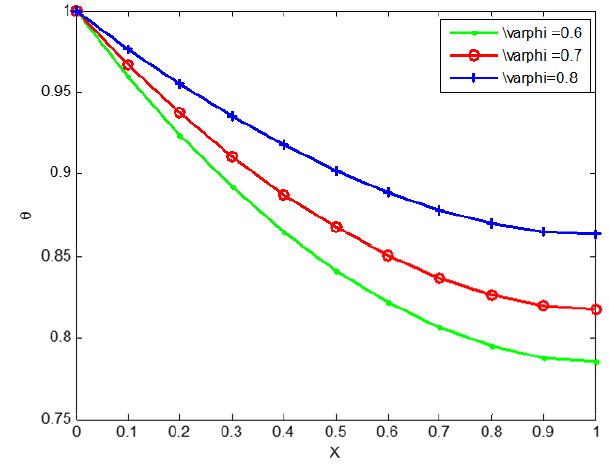
Figure 13. The effect of porosity on the non-dimensional temperature distribution for trapezoidal copper fin